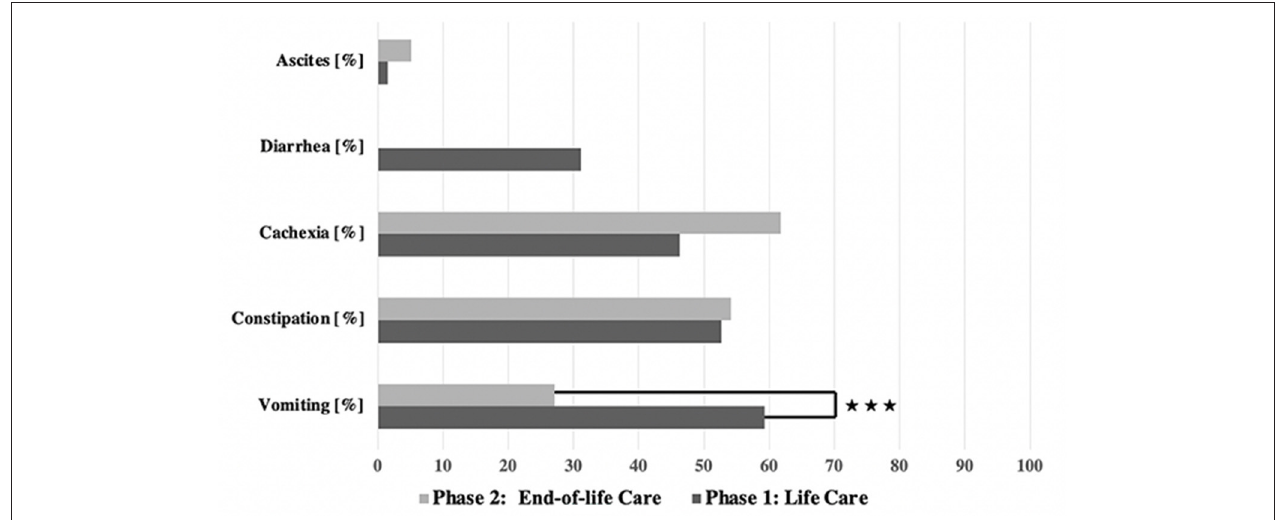
FIGURE 2 | Frequency of symptoms in both groups. *** p < 0.001.